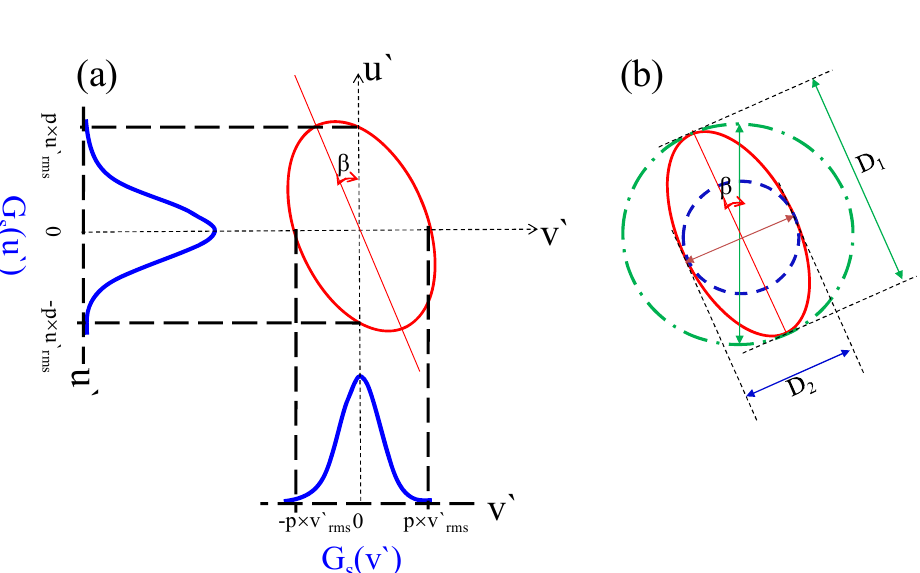
Figure 5 Equi-probability density ellipse and its relation to the two corresponding Gaussian-functional components.